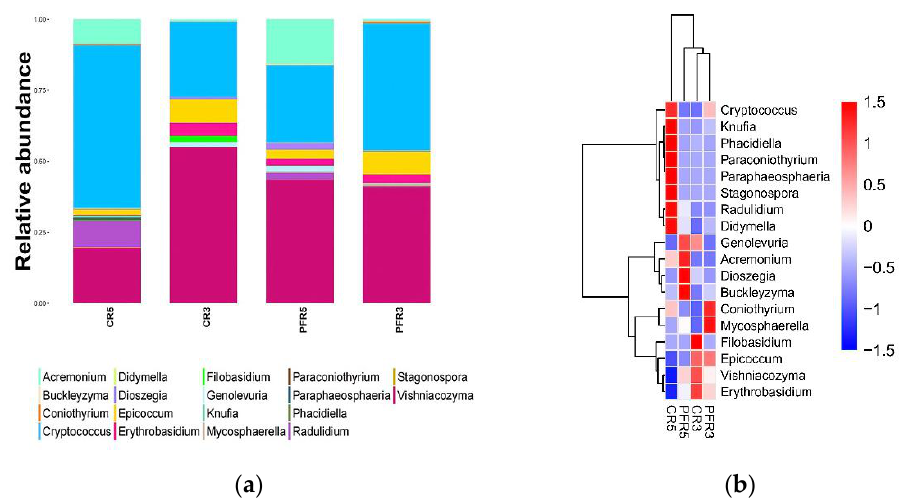
Figure 2. Bar charts ( a ) and heat map ( b ) showing the relative abundance of 18 fungal genera that were present across all samples. In the heat map, blue represents a fungus with relatively low abundance, and red represents a fungus with relatively high abundance. Cluster analyses of samples (Vertical) and genus classification units (horizontal) were performed according to the similarity of distributions.